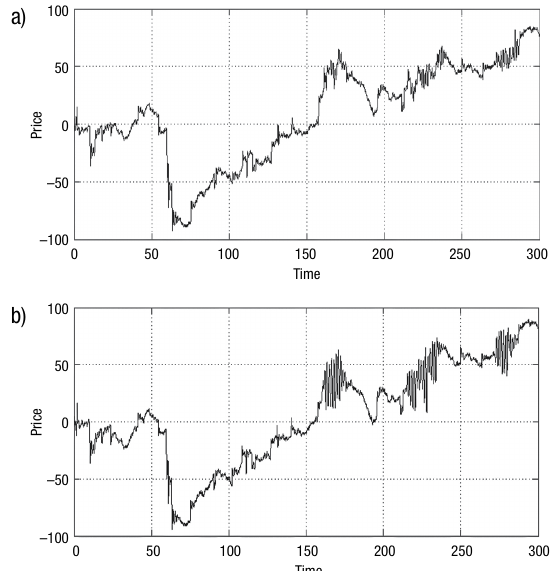
Fig. 19. Simulated path without resonance (a), simulated path with the resonance effect